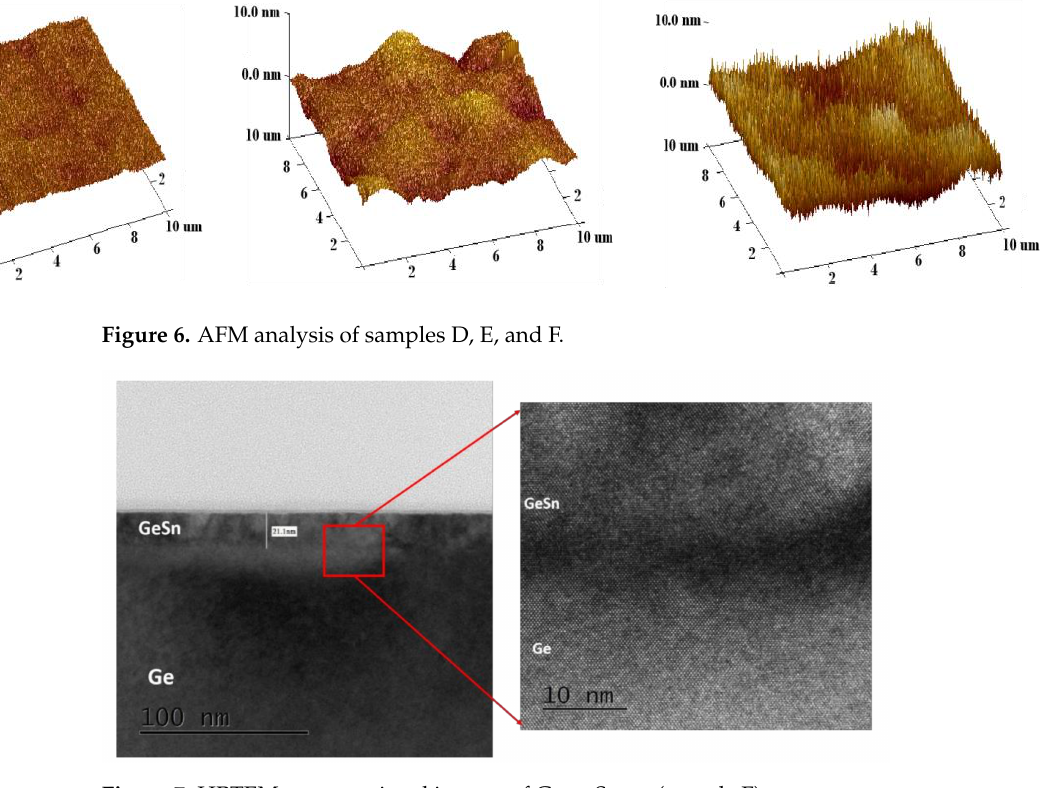
Figure 7. HRTEM cross-sectional images of Ge 0.82 Sn 0.18 (sample F).